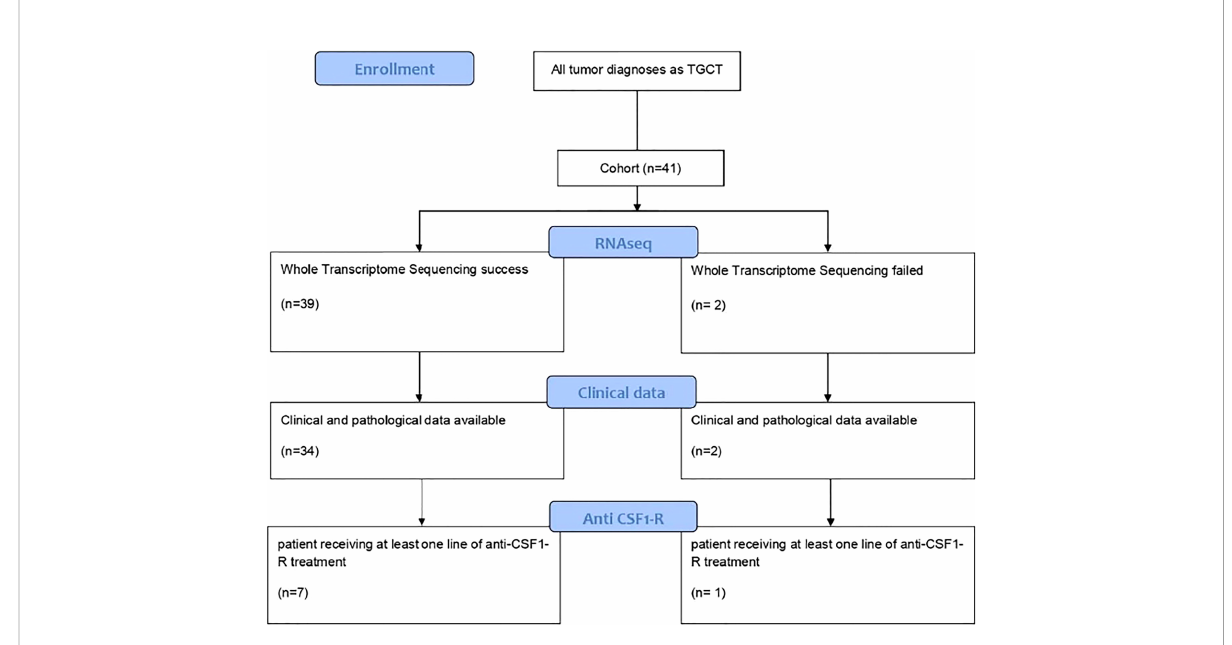
FIGURE 1 Cinsort diagram of patients included in the